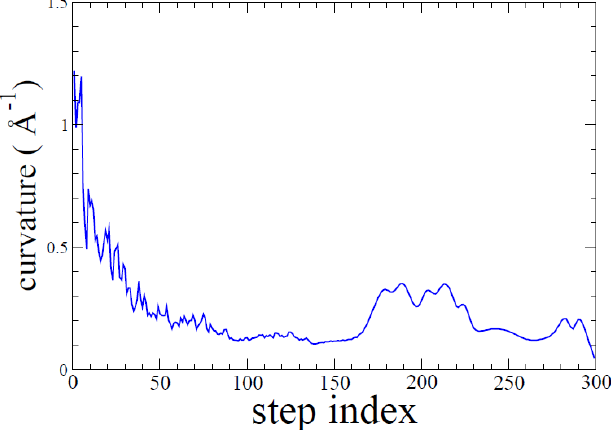
Figure 5. Curvature of the transition pathway calculated by Equation (5) is shown. The radius of curvature ranges between 1.6 and 10.0 Å, and after the step index j = 30 the radius is larger than 3 Å. This means that there exist no abrupt changes of atomic motions along the